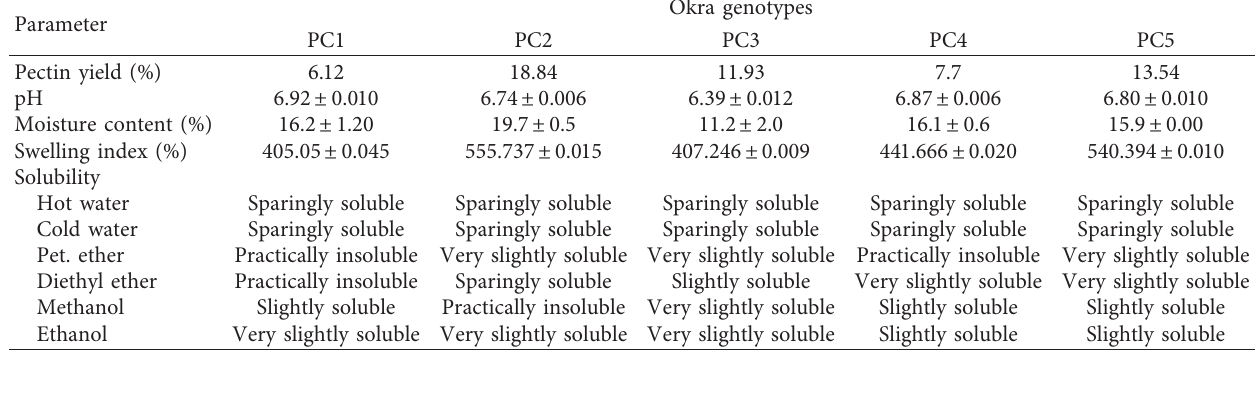
Table 2: Physicochemical properties of the extracted pectin.